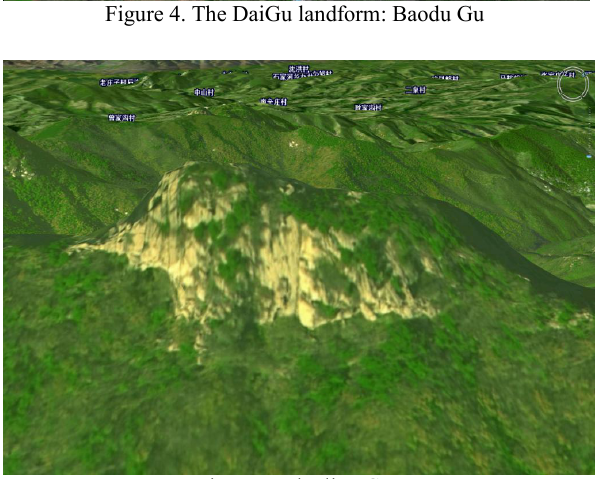
Figure 5. The lion